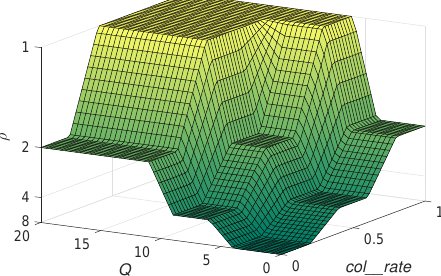
Figure 4. Surface representation of the proposed fuzzy rule-based system (FRBS), normalised to L =